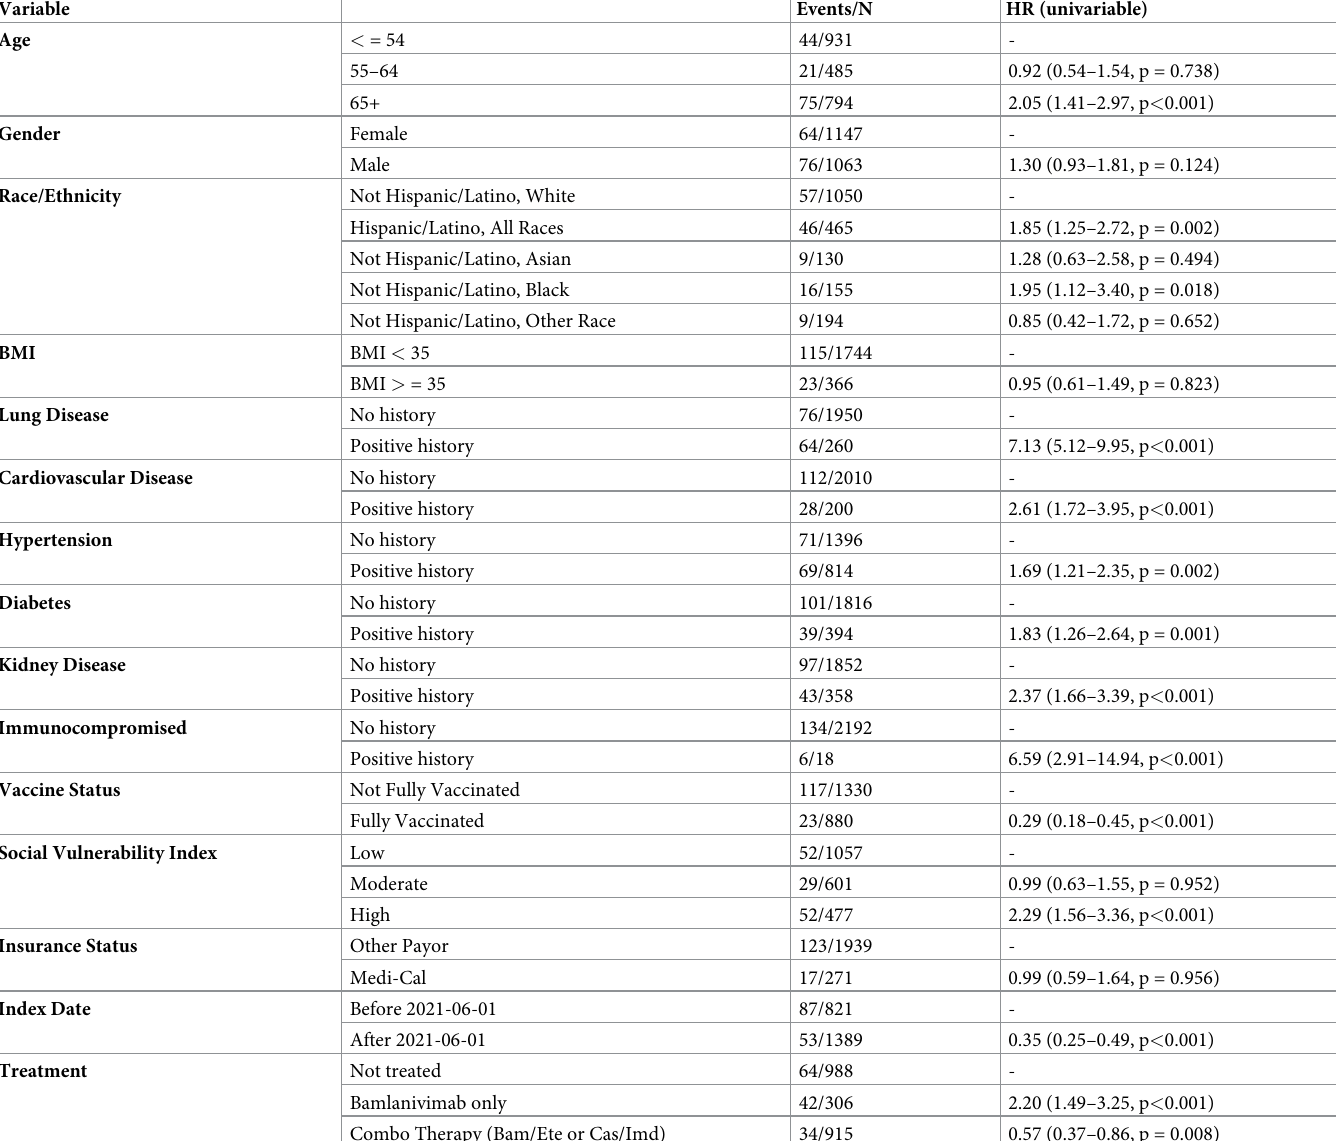
Table 2. Crude Hazard ratios for 30-day risk of ED visit, hospital admission, or death across all treatment groups for selected covariates.